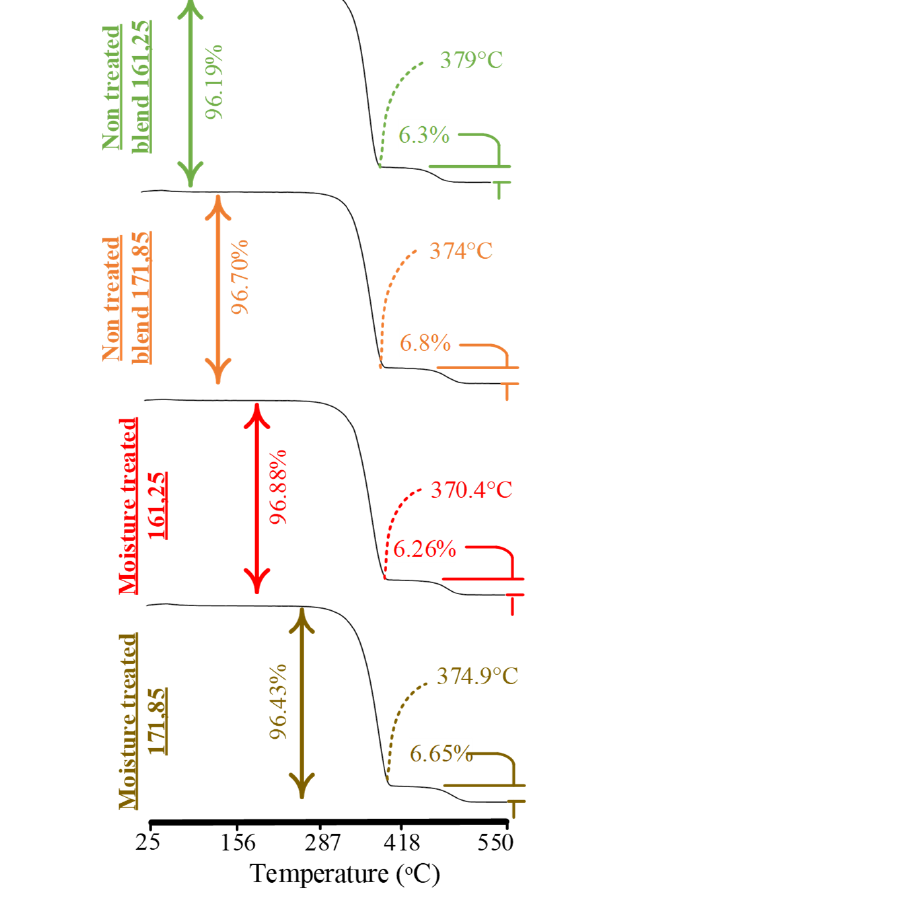
Figure 10. TGA analysis for soil biodegradation and moisture-based (water-absorbed) degradation. Table 7. TGA analysis for the PLA/PP/PE-g-MAH blend.